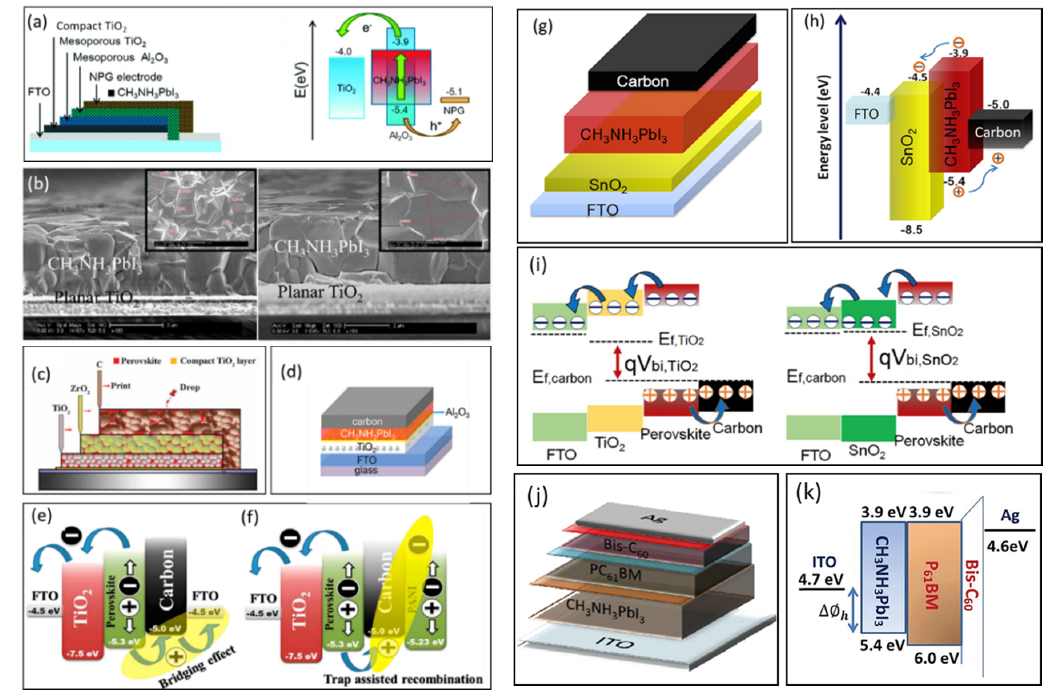
Figure 3. Schematic illustration of the different approaches developed by researchers for HTM-free perovskite solar cell architectures ( a ) with the nonporous gold counter electrode and its corresponding energy bandgap diagram. Reproduced with permission from [26]. Royal Society of Chemistry, 2015. ( b ) Cross-section scanning electron microscopy (SEM) for 8 (left) and 10 (right) perovskite spray passes. Reproduced with permission from [24]. American Chemical Society, 2015. ( c ) Monolithic PSC with perovskite infiltrated in the stacked structure. Reproduced with permission from [38]. American Association for the Advancement of Science, 2014. ( d ) Mesoporous PSC with carbon layer on top of screen printed perovskite layer, and Al2O3 spacer layer. Reproduced with permission from [36]. Wiley-VCH Verlag GmbH & Co. KGaA Weinheim, 2019. ( e ) Schematic of energy band diagrams of FTO-based PSC and ( f ) polyaniline-based PSC, showing the bridging and trapping sites. Reproduced with permission from [46]. Elsevier, 2015. ( g ) Schematic illustration of carbon-based planar PSC with SnO 2 as the ETL and ( h ) the corresponding energy band diagram. Reproduced with permission from [39]. Elsevier, 2019. ( i ) Schematic illustration of the energy band diagram of planar HTM-free PSCs using TiO 2 and SnO 2 as the ETLs, showing their fermi levels. Reproduced with permission from [47]. Elsevier, 2018. ( j ) Schematic illustration of inverted HTM-free structure with PCB61M as the ETL and ( k ) its corresponding energy band diagram. Reproduced with permission from [48]. Royal Society of Chemistry, 2015.